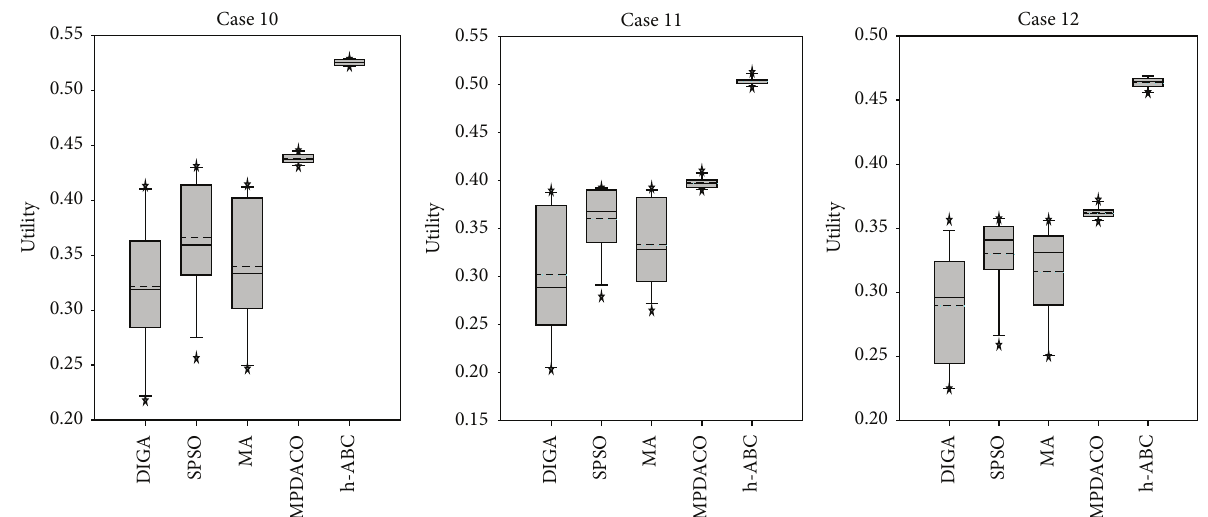
Figure 2: The statistical results of the obtained utilities by the compared algorithms on different